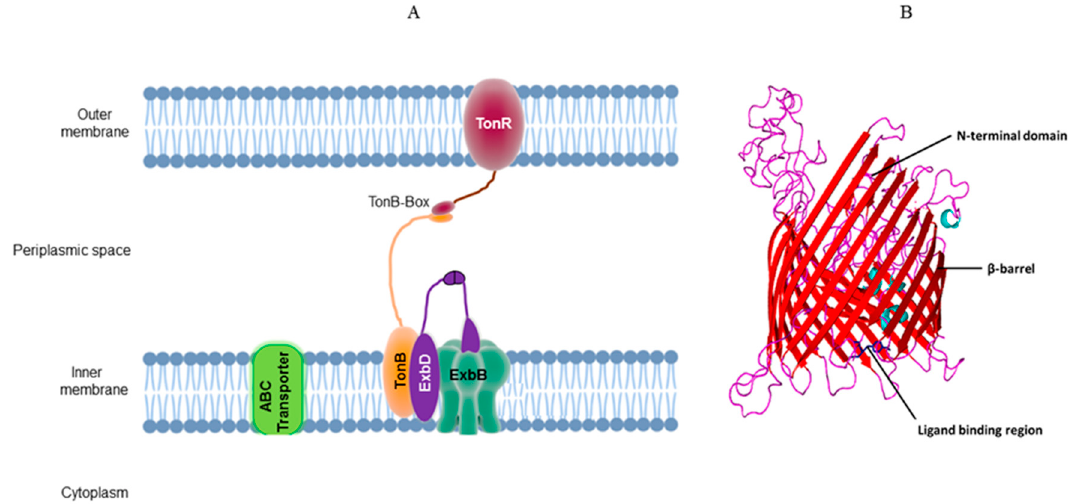
Figure 1. ( A ) Schematic diagram of TonB-dependent transport system. ( B ) Typical structural features of an outer membrane transporter (TBDT), 22 β -barrel structure, N-terminal plug domain, and substrate binding motif are indicated with arrows.